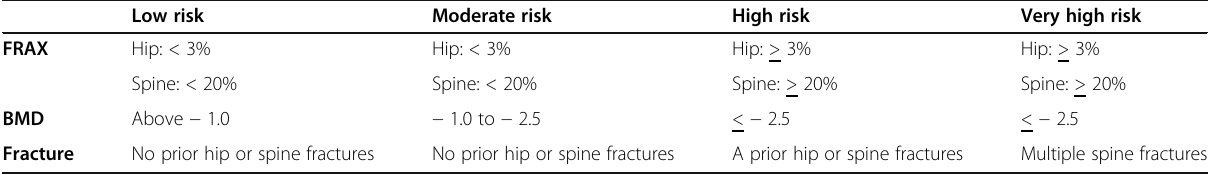
Table 1 Characteristics of the four osteoporosis risk categories identified according to the European Society of